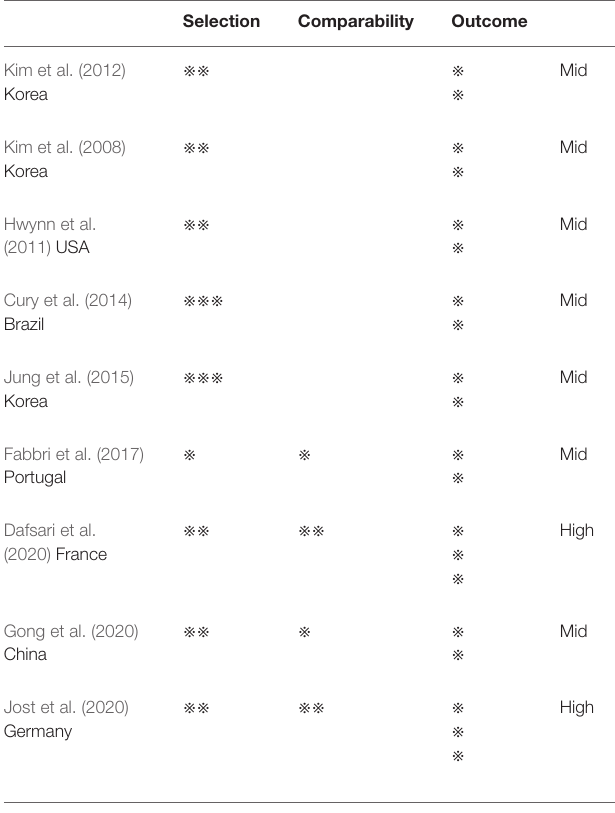
TABLE 1 | Summary of critical appraisal of included studies using the Newcastle-Ottawa Scale for assessing the quality of the studies included.